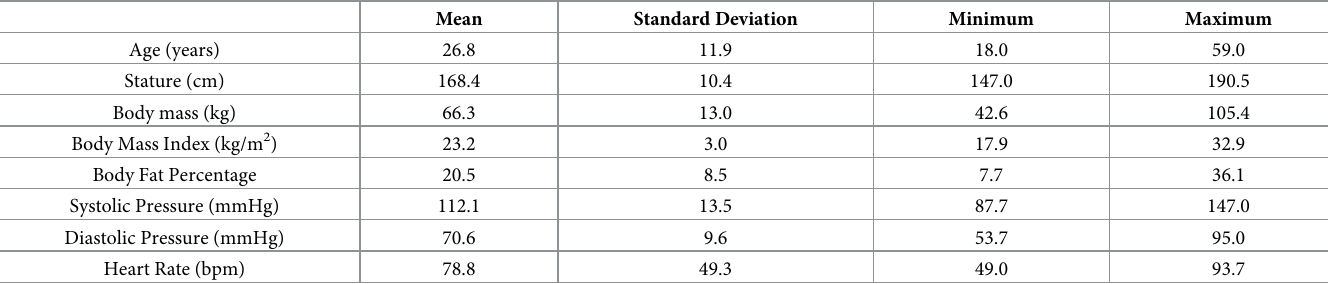
Table 1. Descriptive demographics of the participants ( N = 48).